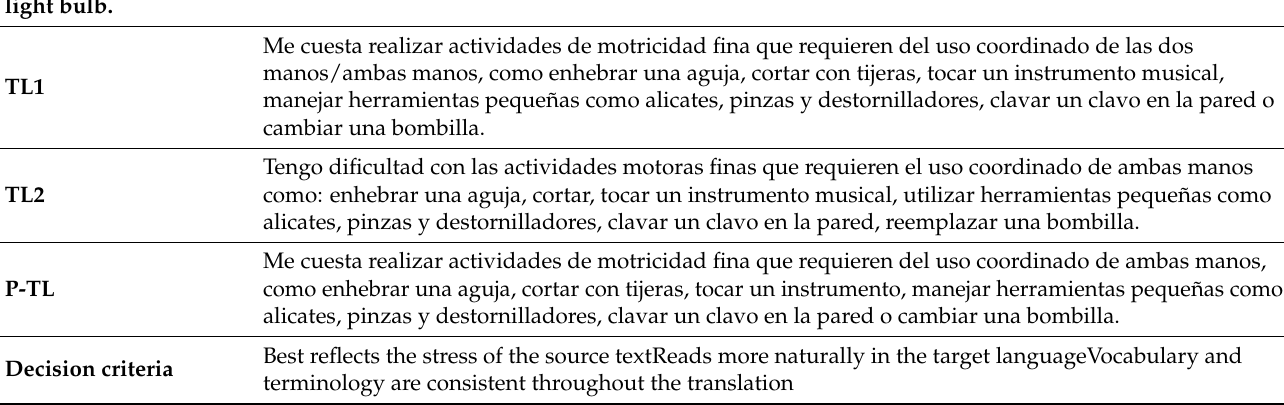
Table 2. Example of items reconciliation and synthesis.